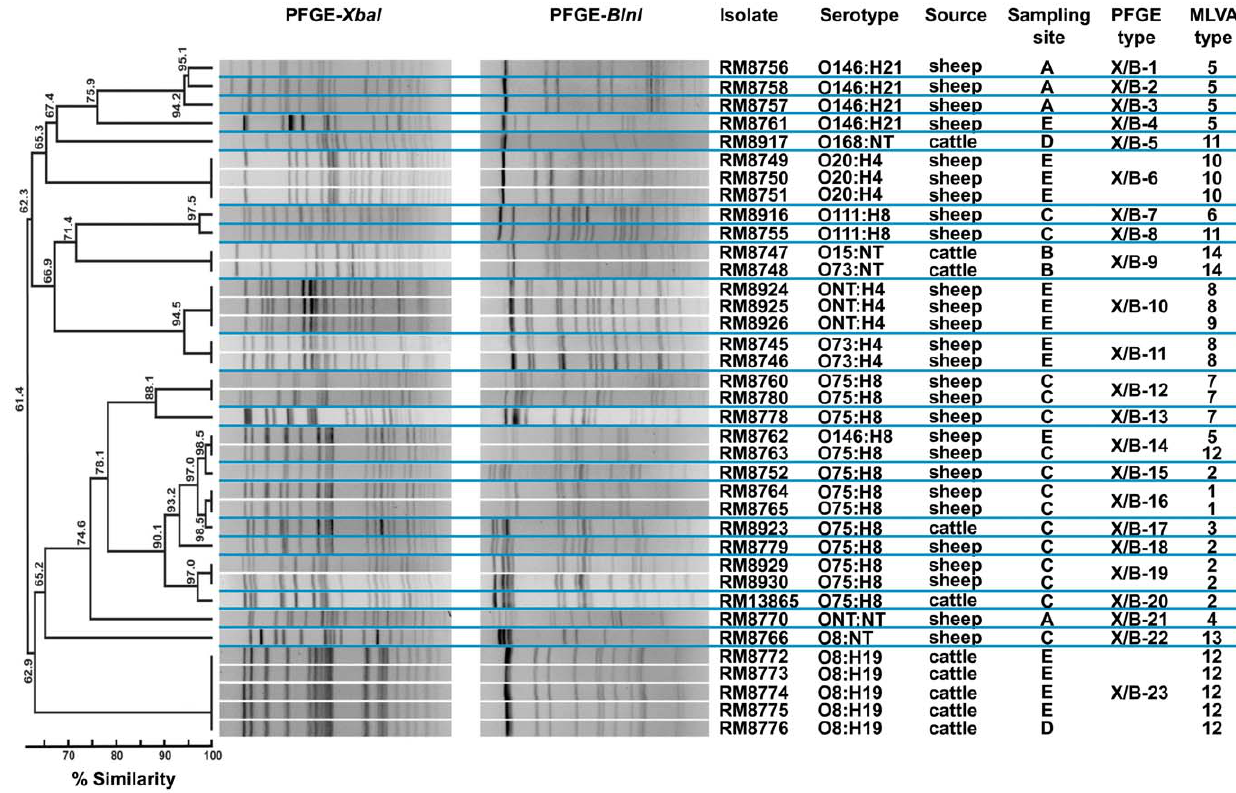
Variable Number Tandem Repeat loci